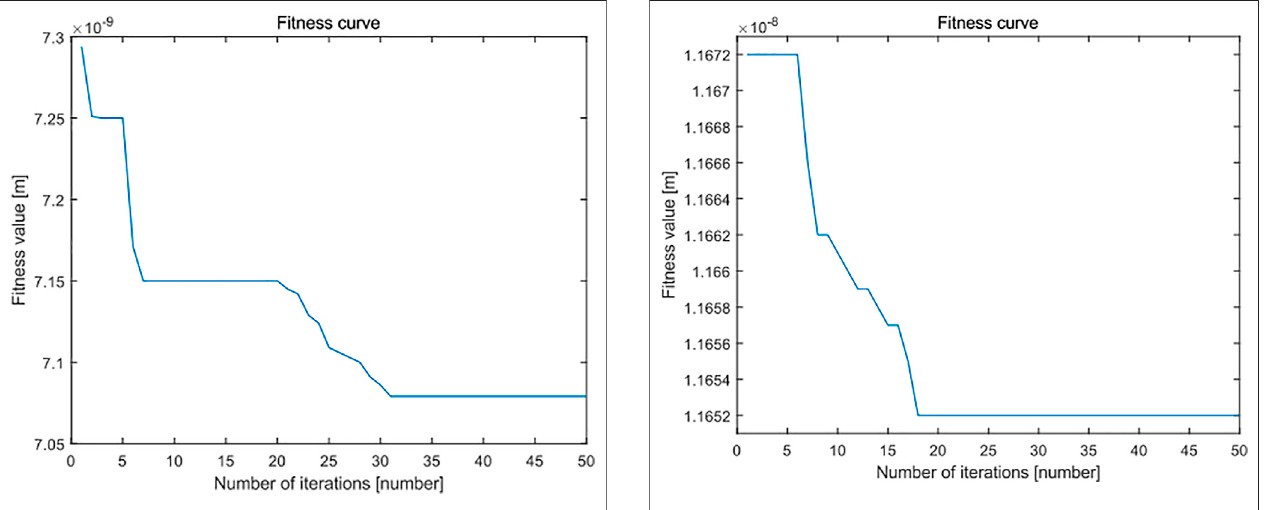
FIGURE17| Fitnesserrorcurveofstandardparticle swarmoptimization algorithm in fl atness error evaluation of the SHS sample of 5 × 5 μ m.